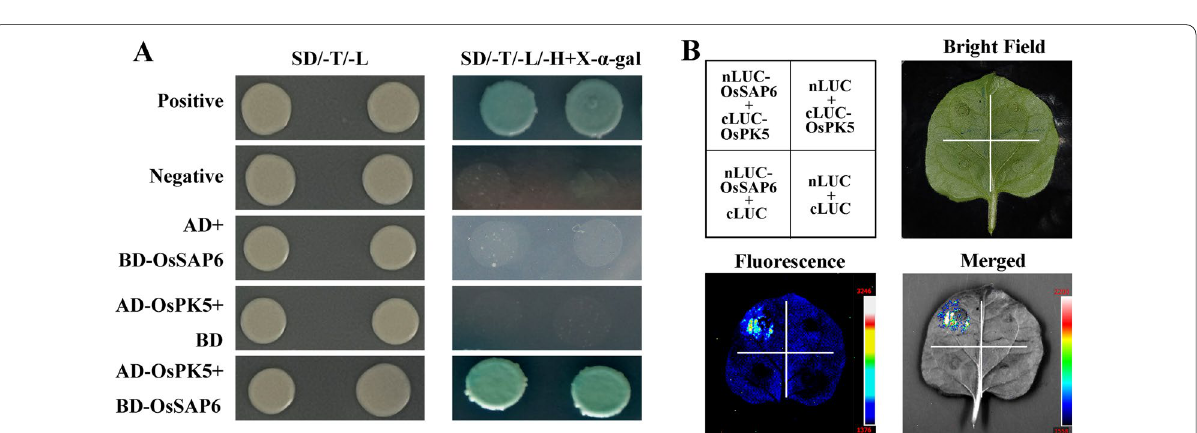
5:1, 3:1, and 2:1, water as a control) for 7 days. The =